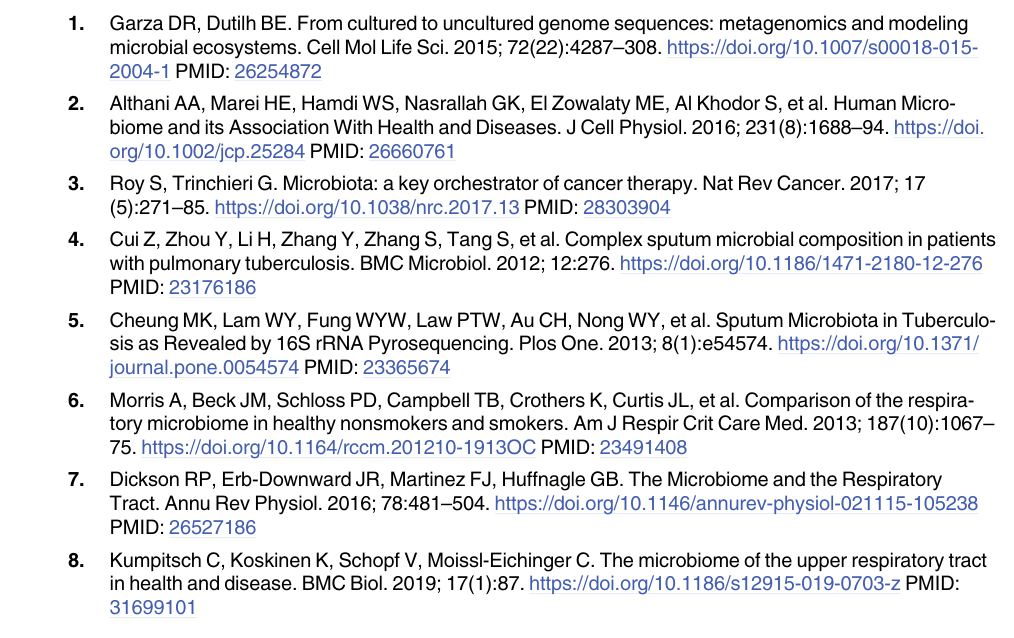
S2 Data. Genus level relative abundance of microbial community in the diabetes group. Genera with an abundance of more than 3% are